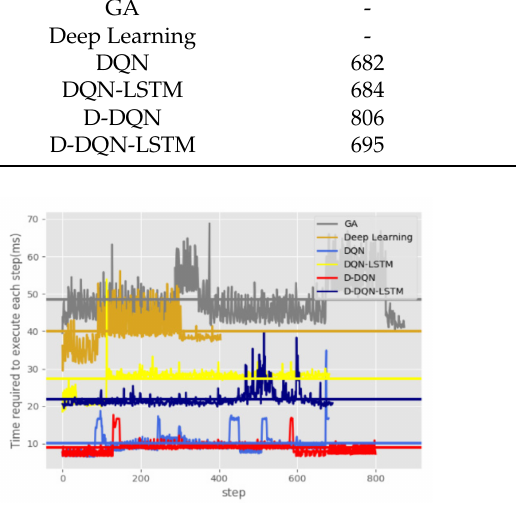
Figure 17. Comparison of the action execution times of the six algorithms in a complicated environment.